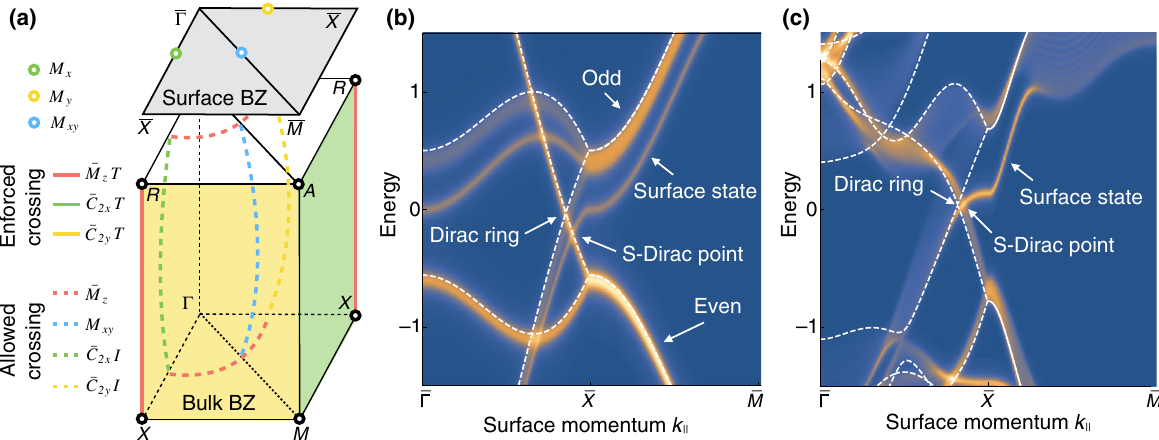
FIG. 4. (a) Schematic of the symmetries of space group P 4 =nmm . Colored planes, lines, and points indicate the symmetry-protected degeneracies in the absence of spin-orbit coupling. Solid colors identify momenta where all states are doubly degenerate due to a combination of a nonsymmorphic symmetry and time reversal; dashed lines represent allowed crossings of bands with different symmetry eigenvalues. At the (001) surface the symmetry is reduced to the symmorphic group P 4 mm . (b) Surface density of states for 0 (dashed white line). (c) Surface density of the effective model in Eqs. (1) and (2), superposed with the bulk band structure at k z ¼ states for a 26-band tight-binding model fitted to the DFT band structure of ZrSiS. The Kramers degeneracy at X is lifted at the surface since the symmetry group is reduced to a symmorphic one. This creates a two-dimensional surface band, since the degeneracy at X is lifted. Here, we call such a band floating band. The effect is mostly visible in bands with large k dispersion, in contrast to planar orbitals, z such as d x 2 − y 2 from the crossing of bands with different symmetry eigenvalues along high symmetry planes (dashed lines).